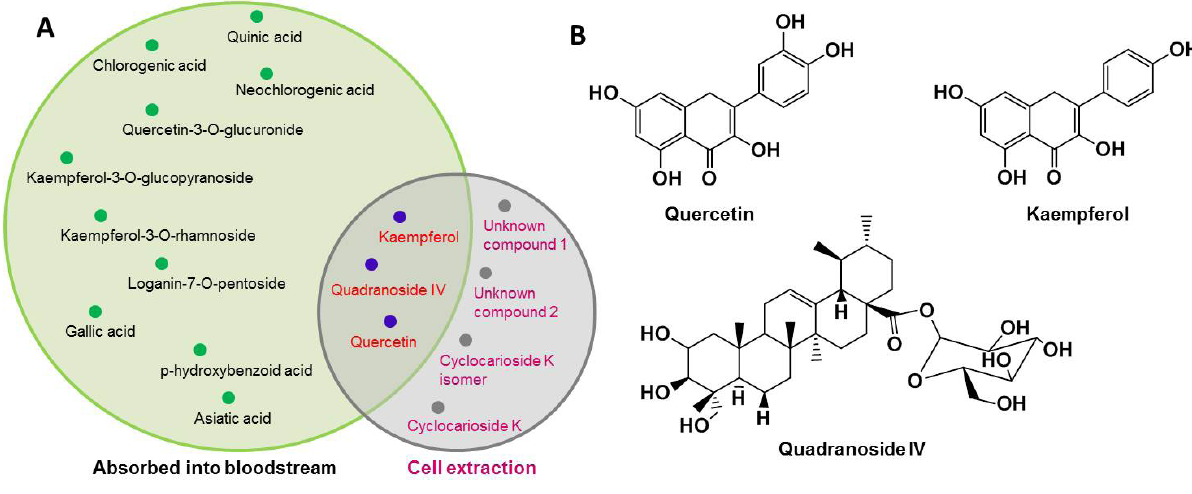
Figure 3: Direct-acting pancreatic protectants identification. (A) Summary of identified potential active components by using serum pharmacochemistry and cell extraction; (B) The structures of identified potential direct acting pancreatic protectants.